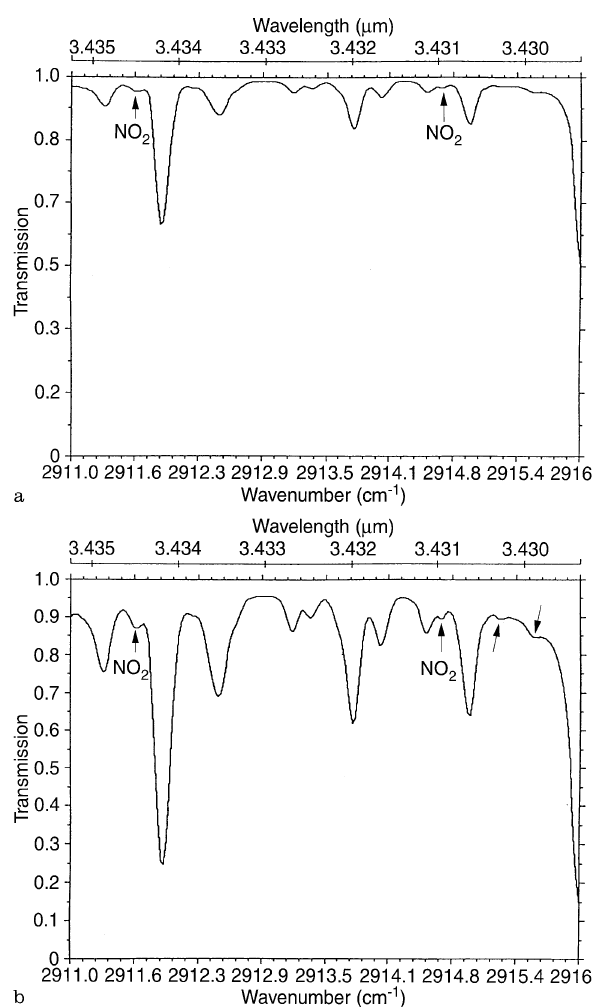
Fig. 7. Simulated atmospheric spectra in the 1330 — 1340 cm (cid:126)(cid:49) spec- tral range containing significant HNO (cid:51) absorptions, corresponding to MIRAS measurements at 25 km tangent altitude